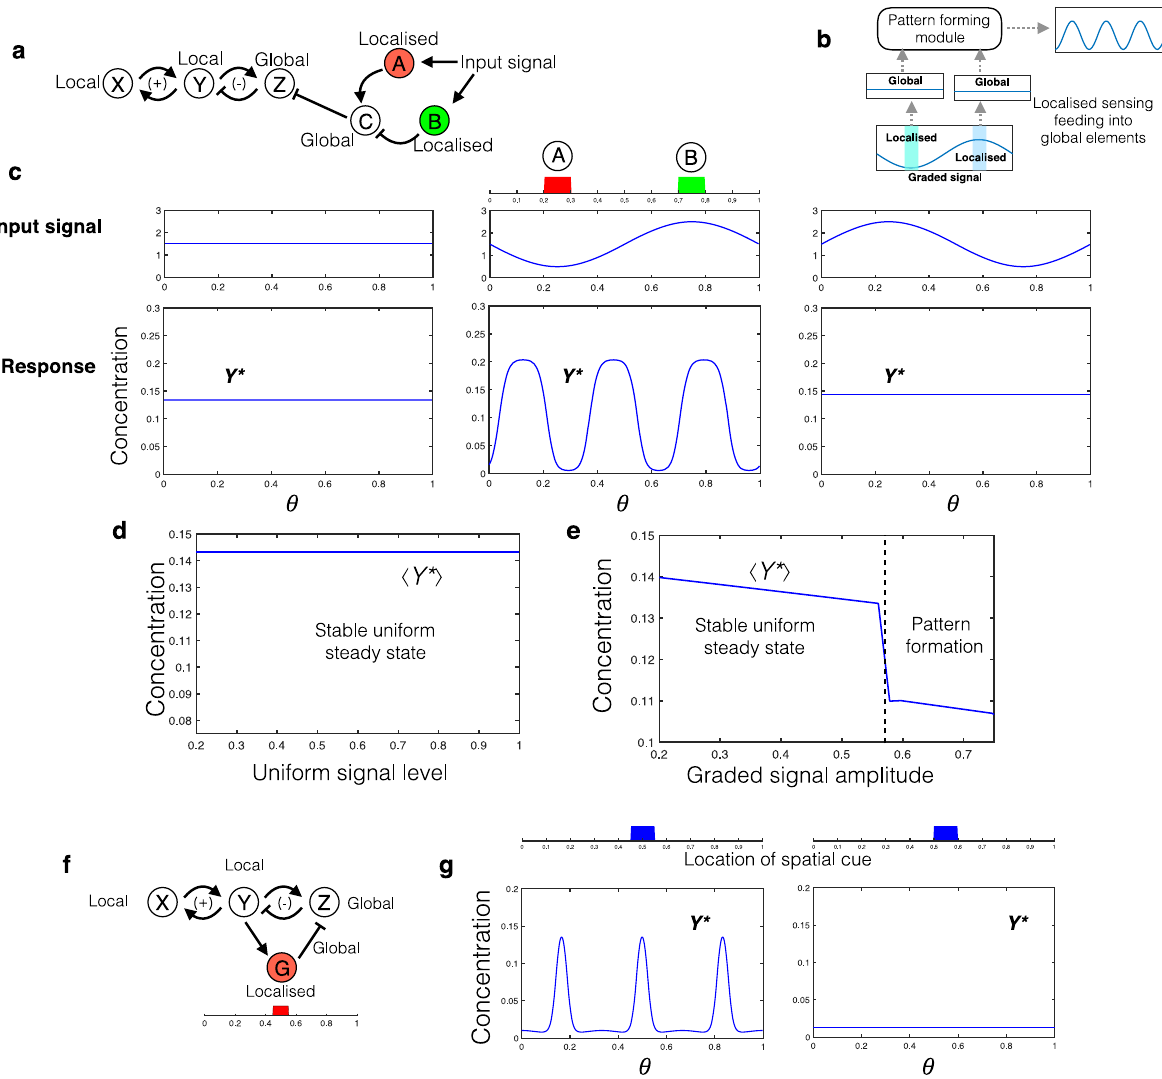
Fig. 5 Localisation as a regulator of pattern formation. a Schematic of hybrid pattern-forming motif, where information from the input is processed through two localised nodes feeding into a global node. b Schematic depiction of how motif in ( a ) can give rise to patterns in a gradient, without distortions introduced by the gradient. c Response to uniform and graded signals. A uniform signal cannot trigger pattern formation, while a graded signal with the same spatial average can produce a pattern. Furthermore, triggering pattern formation also depends on the phase of the gradient in the signal. d Varying a spatially uniform signal over a range does not elicit a patterning response: the steady states are uniform with zero spatial amplitude. e Spatial average output of node Y as a function of the amplitude of the graded input signal (signal average same as in ( c )). The discontinuity indicates the onset of pattern formation, as the amplitude of the gradient is increased. f Schematic of a feedback control structure allowing for phase selection in pattern formation (periodic boundary conditions). g The initial conditions are set by a transient spatial cue (input to Y). Initial conditions with a peak in Y at (or close to) the location of the localised feedback node G lead to a steady state pattern (left panel) with a peak in Y at this location, while other initial conditions do not (right panel). This demonstrates how patterns with particular phases may be selected for, by the con fl uence of localised and global elements in